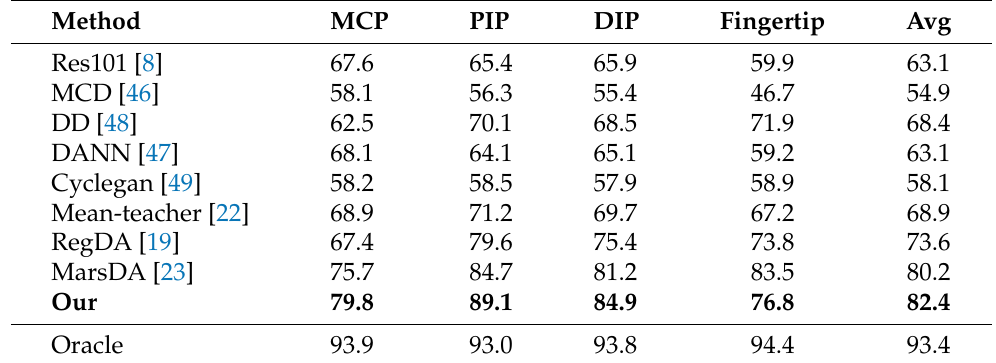
Figure 3. Accuracy of different models during training. Table 2. Results on the task RHD → STB. The last row (oracle) denotes the results of training with target domain labels. The best performance is achieved by our MarsDA.